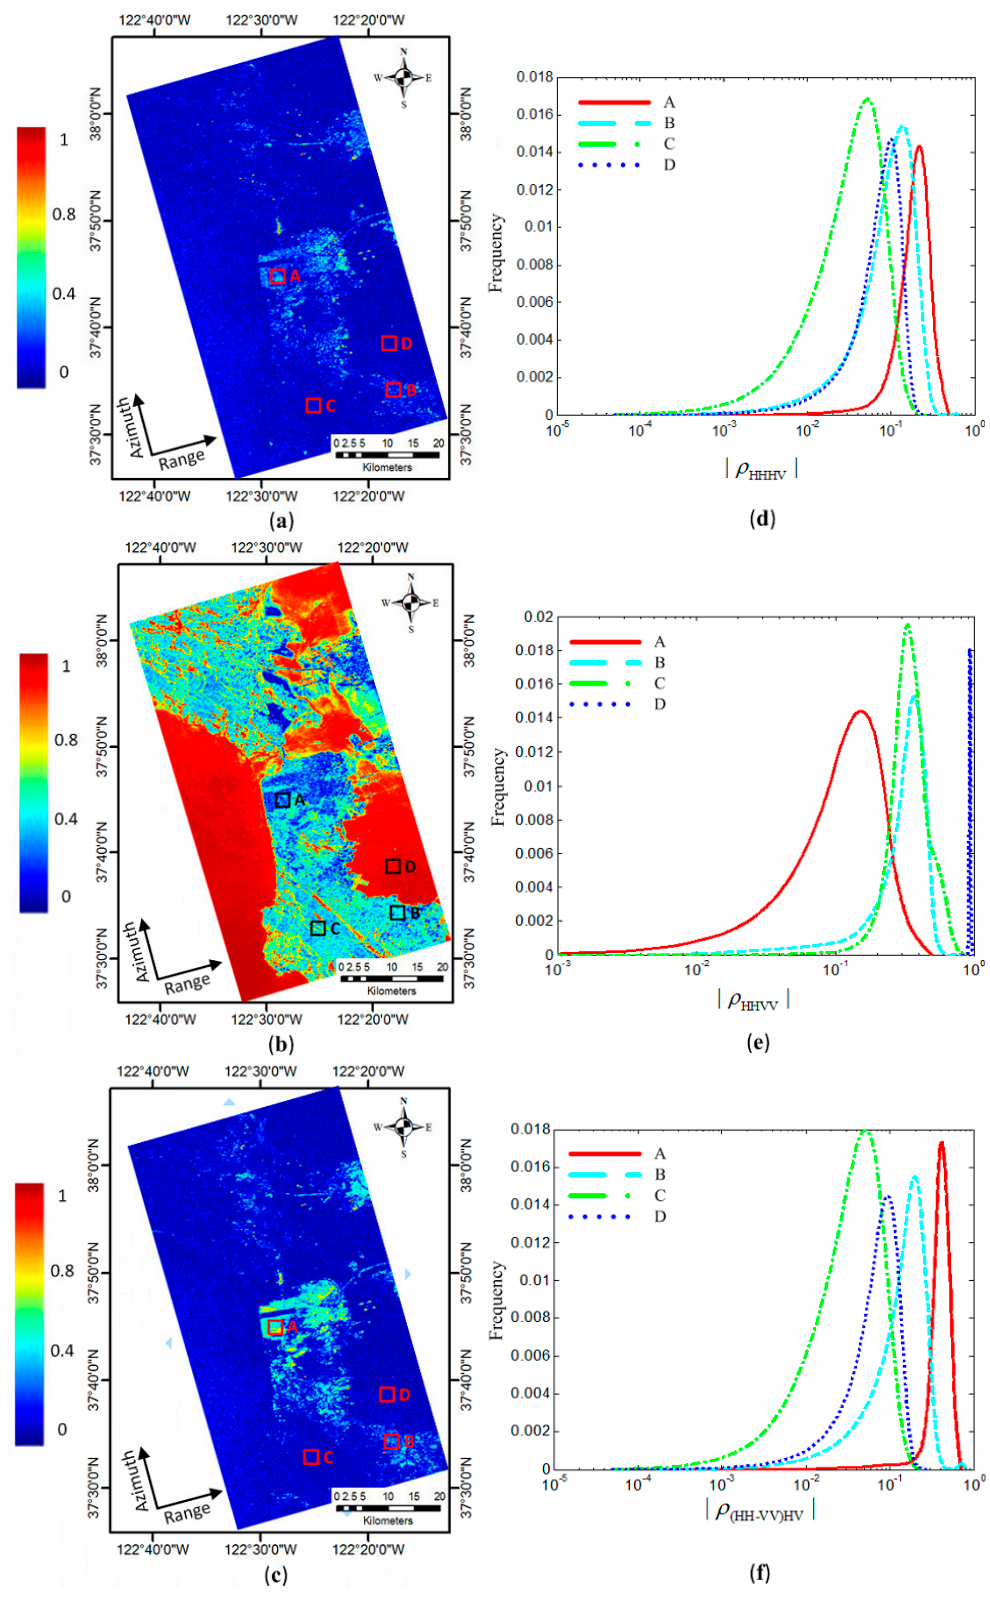
Figure 6. Magnitudes of correlation coefficients and histograms of selected patches: ( a , b , c ) the magnitudes of (cid:2025) (cid:2892)(cid:2892)(cid:2892)(cid:2906) , (cid:2025) (cid:2892)(cid:2892)(cid:2906)(cid:2906) , and (cid:2025) ((cid:2892)(cid:2892)(cid:2879)(cid:2906)(cid:2906))(cid:2892)(cid:2906) , respectively; and ( d , e , f ) the histograms of the four selected patches in ( a , b , c ), respectively.